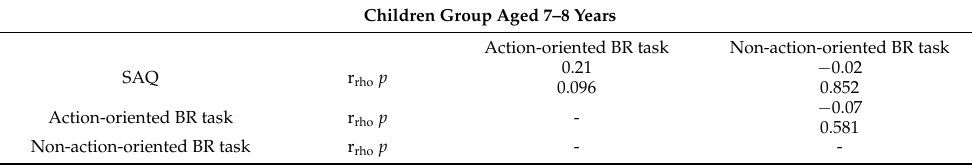
Figure 1. Means with 95% confidence interval error bars in the five age groups for the experimental measures. SAQ score ( A ), action-oriented BR task score, represented by the sum of correct responses ( B ), and non-action-oriented BR task score, represented by the sum of millimeters of deviation from the correct location of each body part ( C ). In panel C the Y -axis is inverted for easier comparison to panel B. SAQ, Self-Awareness Questionnaire; BR, body representation. Table 1. Correlations between SAQ total score and scores of the action- and non-action-oriented BR tasks for each age